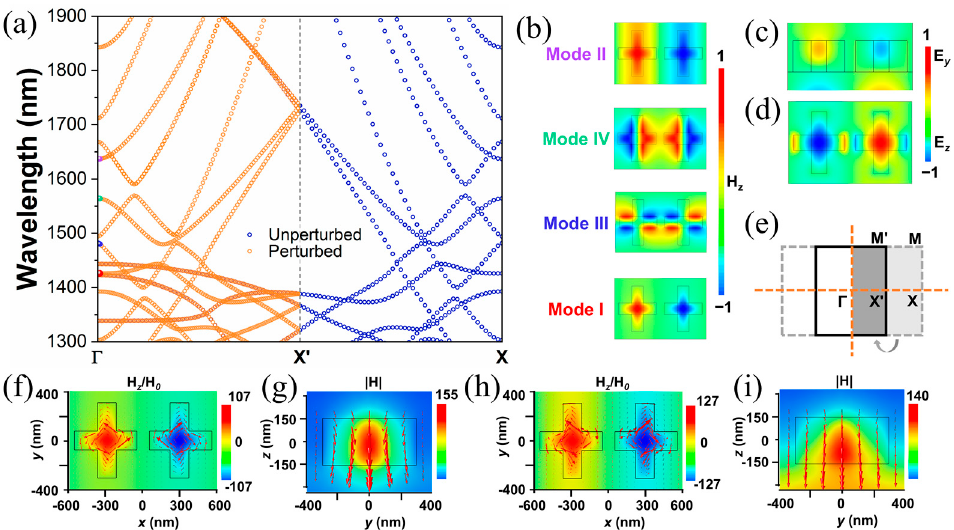
Figure 2. ( a ) Numerically simulated band diagram for unperturbed and perturbed designs. Four target wavelengths are highlighted in color point Γ . The unperturbed geometrical configurations are the same as those in Figure 1a. The magnitude of perturbation is ∆ L = 1 nm. ( b ) Out-of-plane magnetic field components of the perturbed structure for four target modes. ( c ) The y-component of the electric field for mode IV. ( d ) Out-of-plane electric field component for mode III. ( e ) First Brillouin zone of the unperturbed and perturbed lattices. ( f – i ) The electromagnetic field distributions when ∆ L is 10 nm, corresponding to Figure 1e. The normalized z component of magnetic field distributions with displacement current density at a resonant wavelength for mode I ( f ) and mode II ( h ) in the x–y plane. The normalized magnetic distribution in the y–z plane at x = 300 nm for mode I ( g ) and mode II ( i